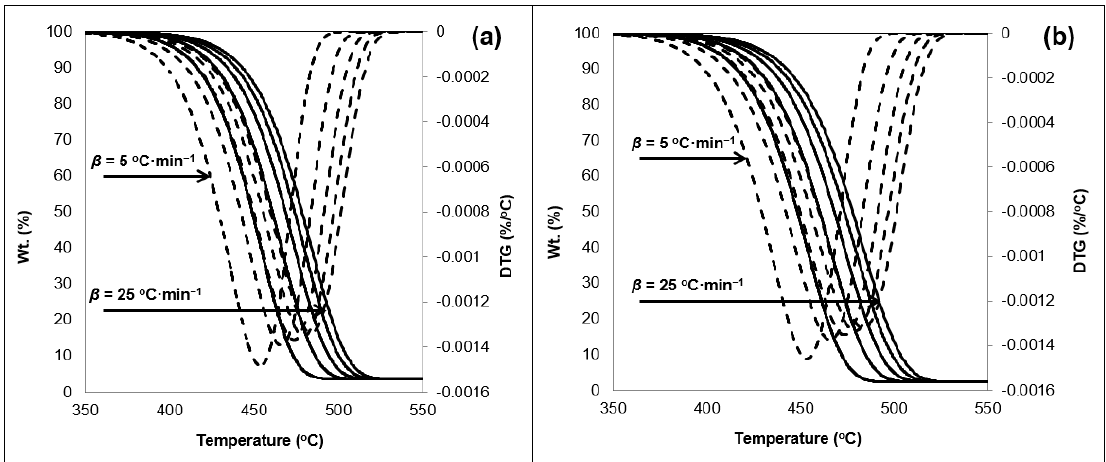
Figure 2. TGA thermogram showing weight loss ( — ) and first derivative (- - -) of the 25/75 sample ( a ) pre-exposure and ( b ) exposed to 11 days in N 2 atmosphere with respect to heating rates (5 to 25 °C·min − 1 ) in sequential order.